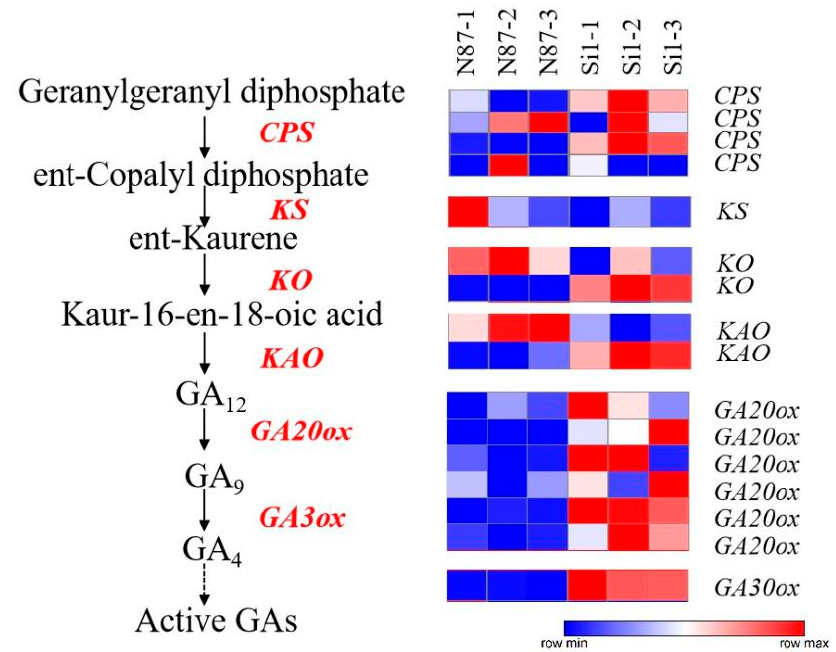
Figure 5. Analysis of the expression of GA biosynthetic related genes regulated by GAs.